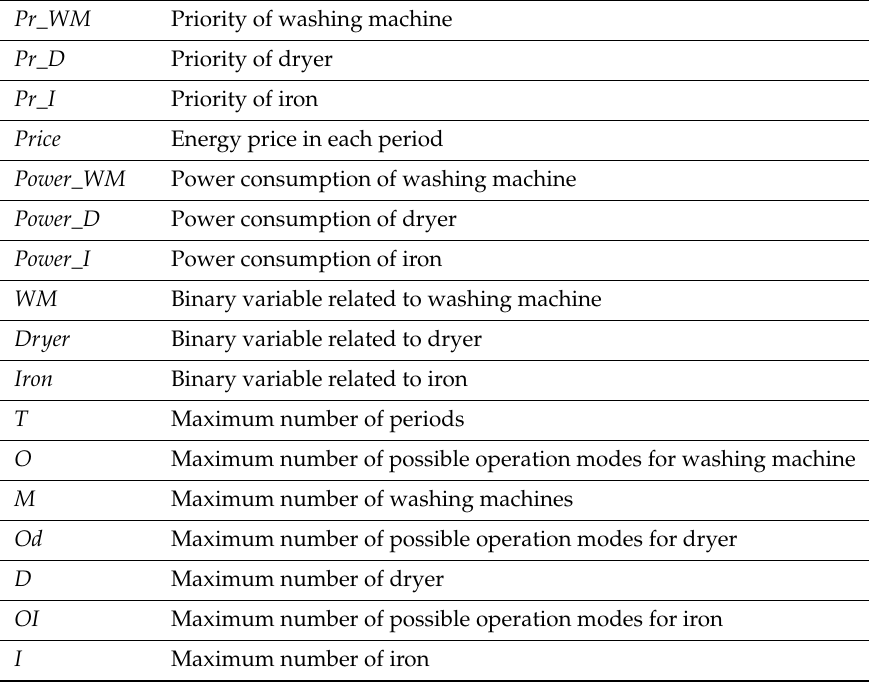
Table 1. Definition of parameters in